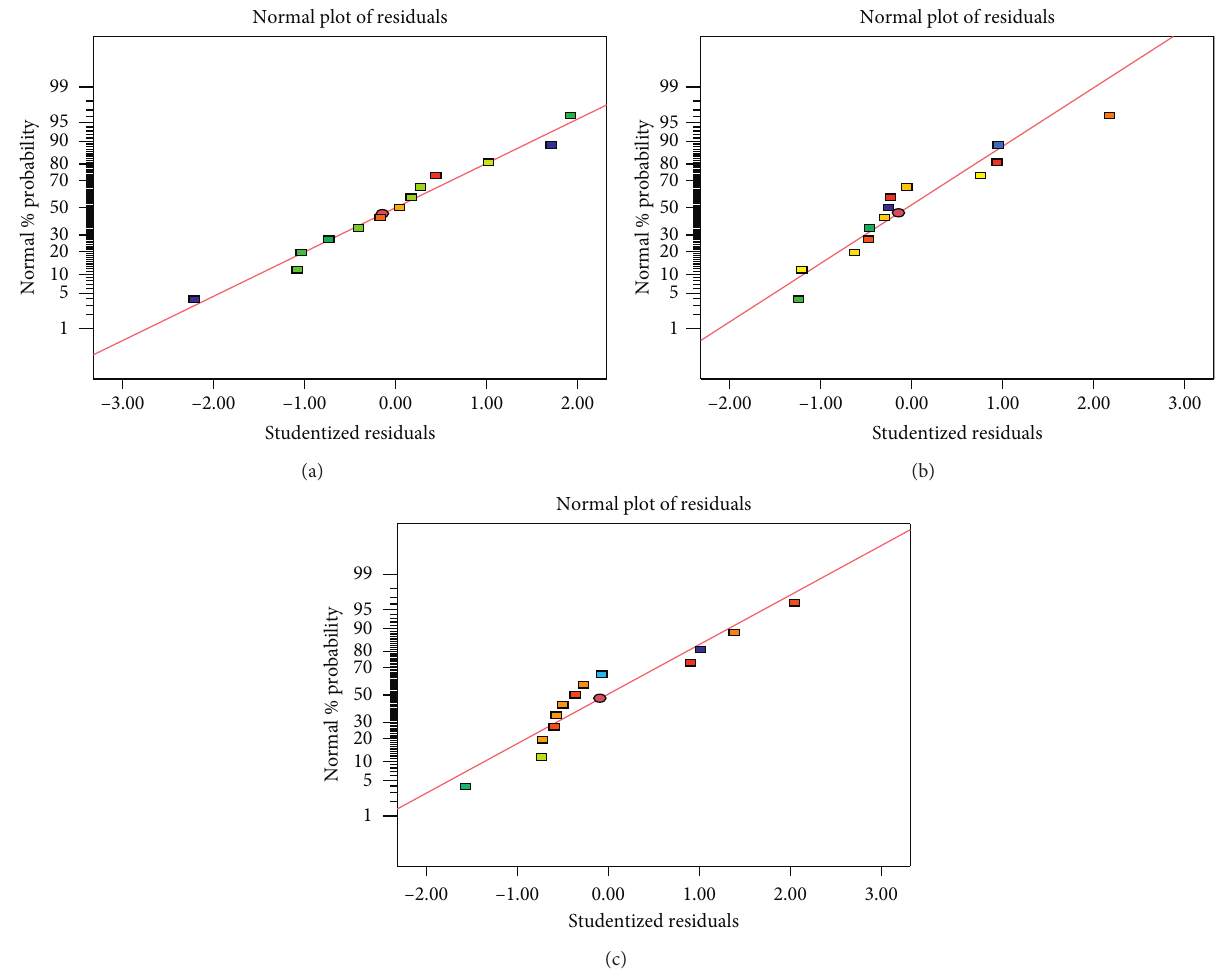
Figure 12: Normal distribution of residuals: (a) 28-day compressive strength (R1); (b) 28-day flexural strength (R2); (c) 28-day flexural- compressive ratio